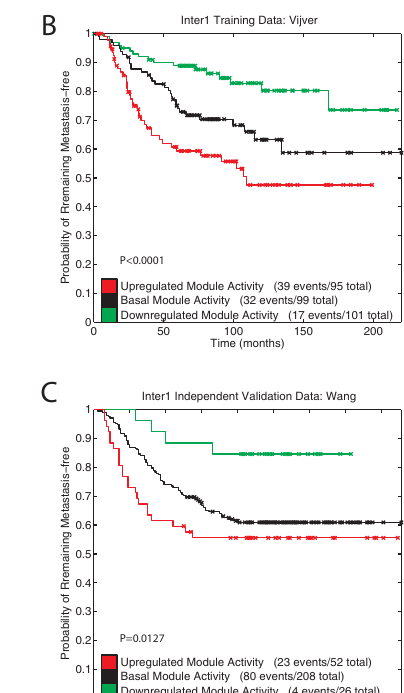
Figure S1 Methodology overview. Overview of the unsupervised module extraction procedure, followed by a supervised investiga- tion of the relation between module expression and conditions. In